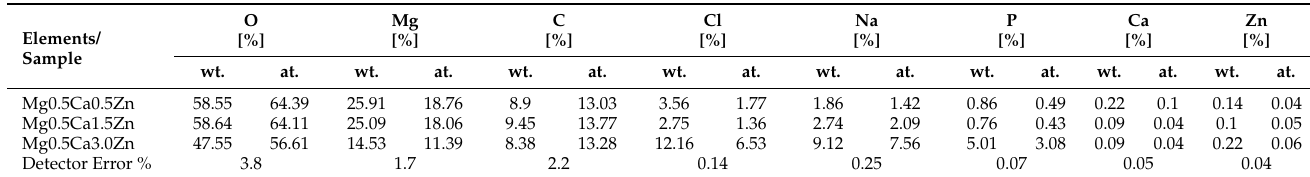
Table 5. Chemical composition of the surface after immersion in SBF and ultrasound cleaning (30 min in technical alcohol, the results represent an average value of three determinations on a 1 mm 2 surface).